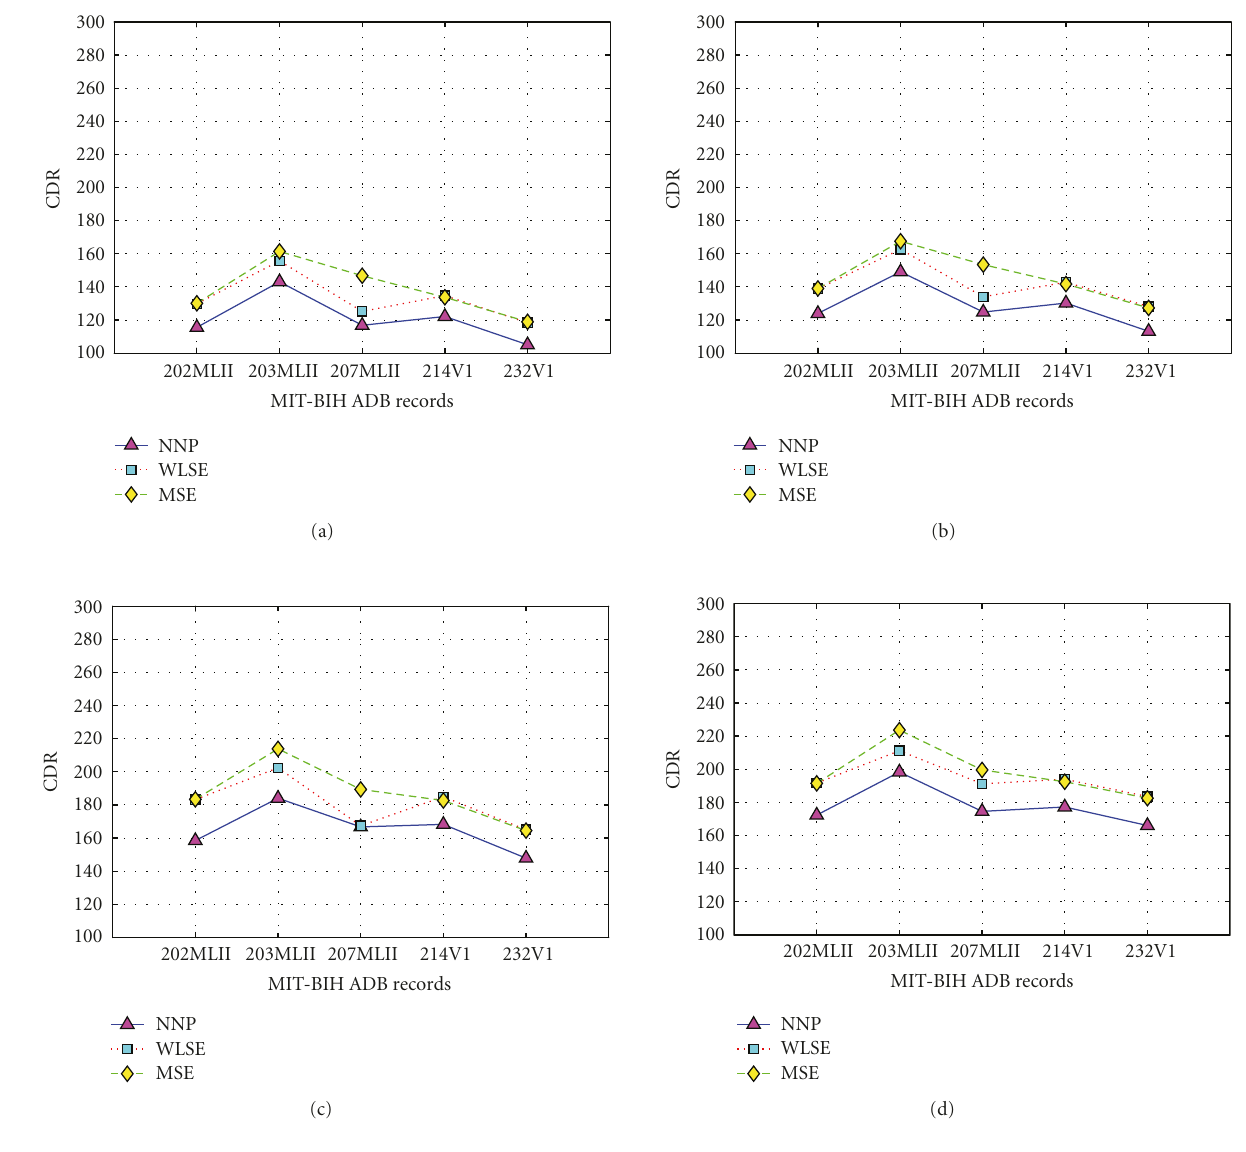
Figure 17: Compressed data rate (CDR) performance results. (a) PH scheme, (b) PRH scheme, (c) PA scheme, and (d) PRA